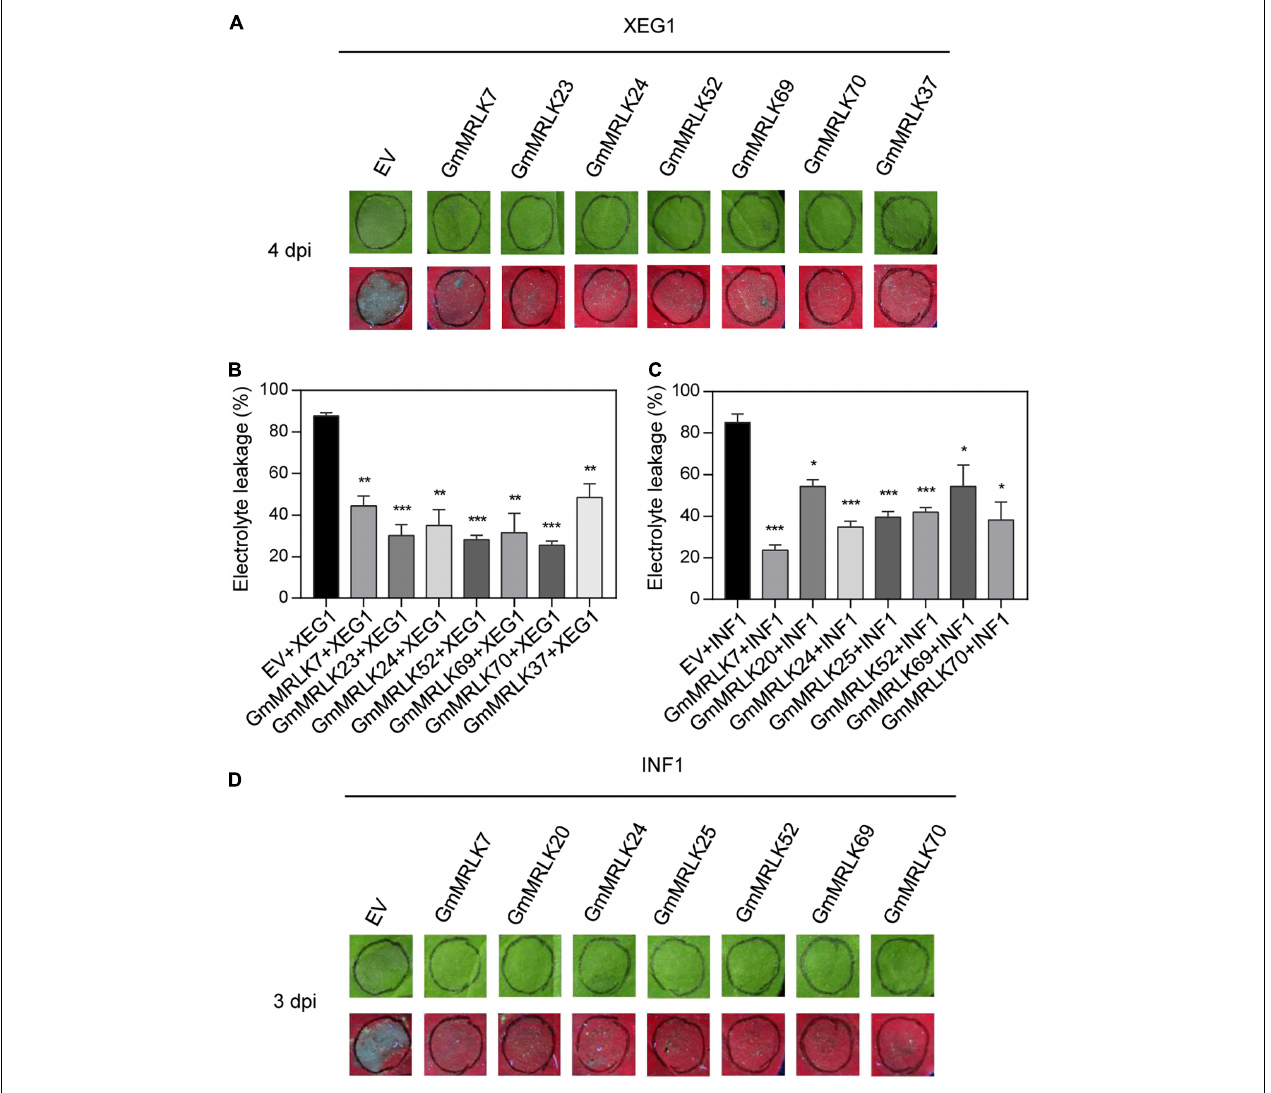
FIGURE 4 | GmMRLKs suppress XEG1- and INF1-induced cell death. (A,B) GmMRLKs suppress P. sojae -derived PAMP XEG1-induced cell death. The indicated GmMRLKs were transiently expressed in N. benthamiana for 1 day, and infiltrated with Agrobacterium carrying XEG1. The cell death phenotype was examined by taking photograph under UV light (A) and measuring the electrolyte leakage (B) . (Mean ± SD, n ≥ 8, student’s t -test; ** p < 0.01, *** p < 0.001). (C,D) GmMRLKs suppress P. infestans -derived PAMP INF1-induced cell death. The indicated GmMRLKs were transiently expressed in N. benthamiana for 1 day, and infiltrated